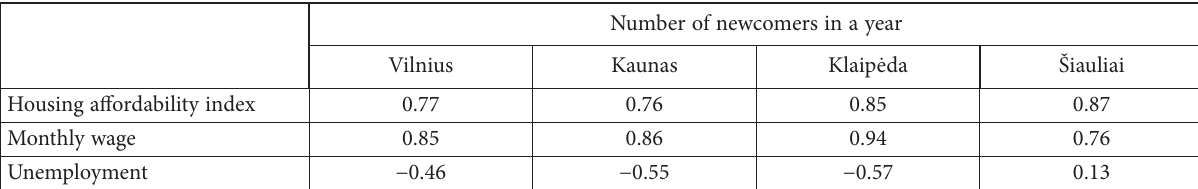
Table 1. Correlation coefficients between the number of newcomers to a certain Lithuanian city from other locations (hereinafter referred to as number of newcomers) and other variables Number of newcomers in a